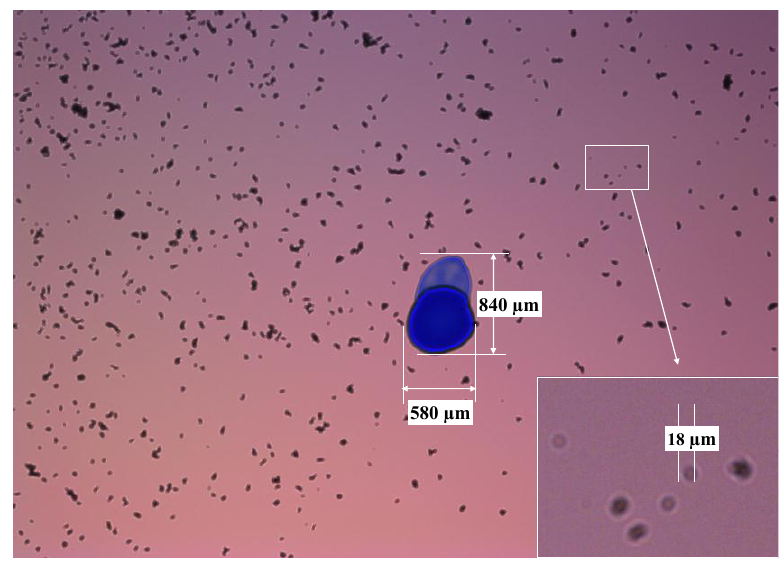
Figure 19. Sample image acquired with the sensor mounting the BK7 glass disk of 0.2 mm. Sensors 2017 , 17 , 586